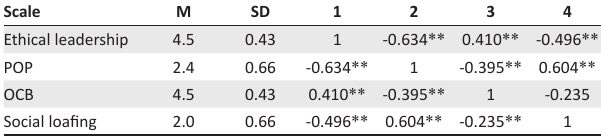
TABLE 5: Means, standard deviations and correlations.